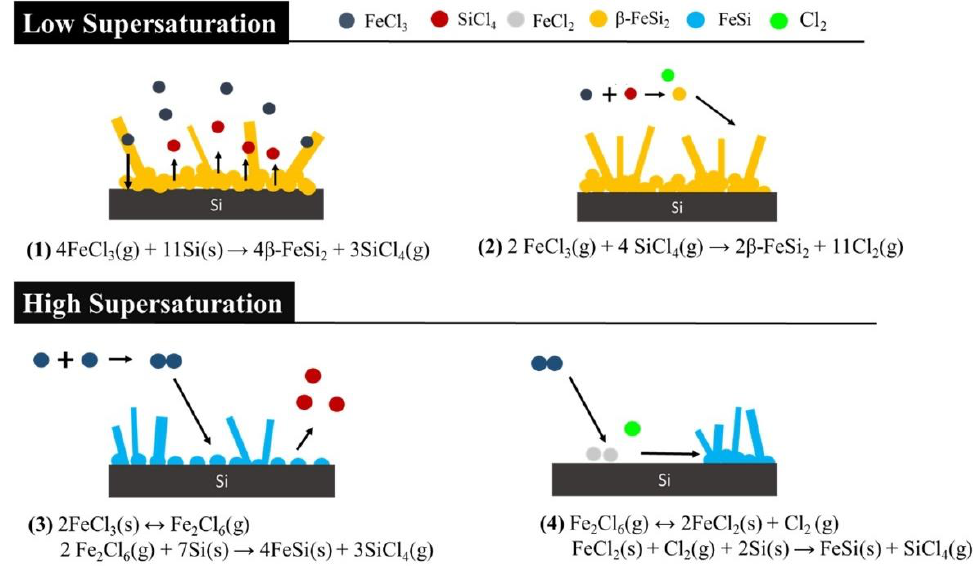
Figure 7. The growth mechanism of iron silicide nanowires.